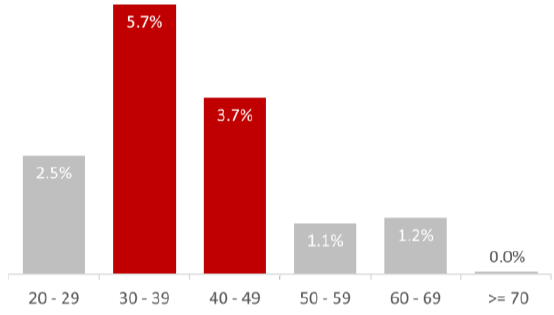
Figure 7. Associations between healthcare-related merchant categories.